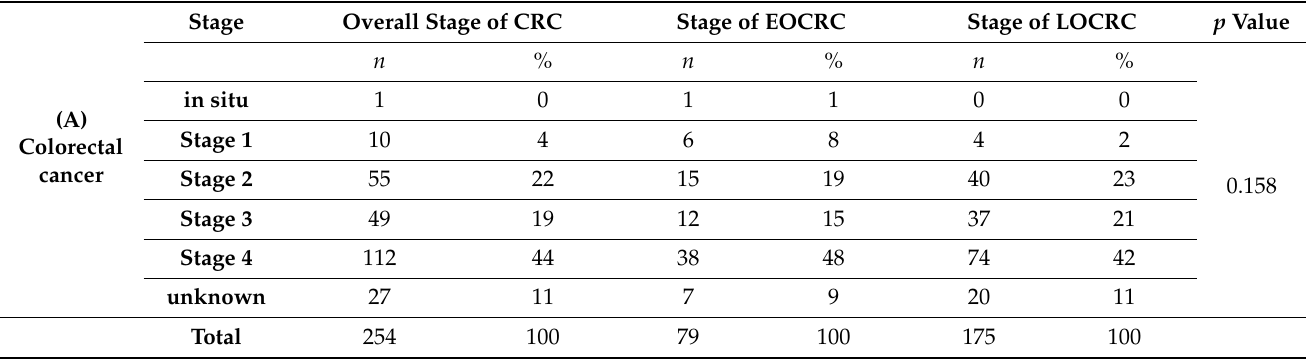
Table 3. Distribution of stage among ( A ) Colorectal cancer, ( B ) Rectal cancer.